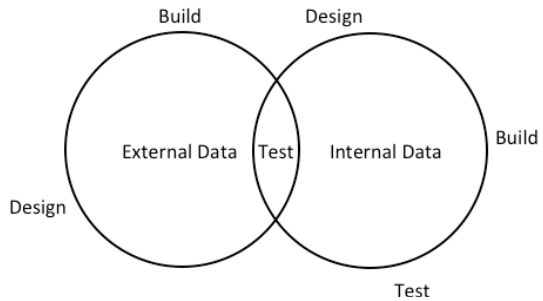
Figure 7. Abstraction of the consequent external and internal data iteration loops.